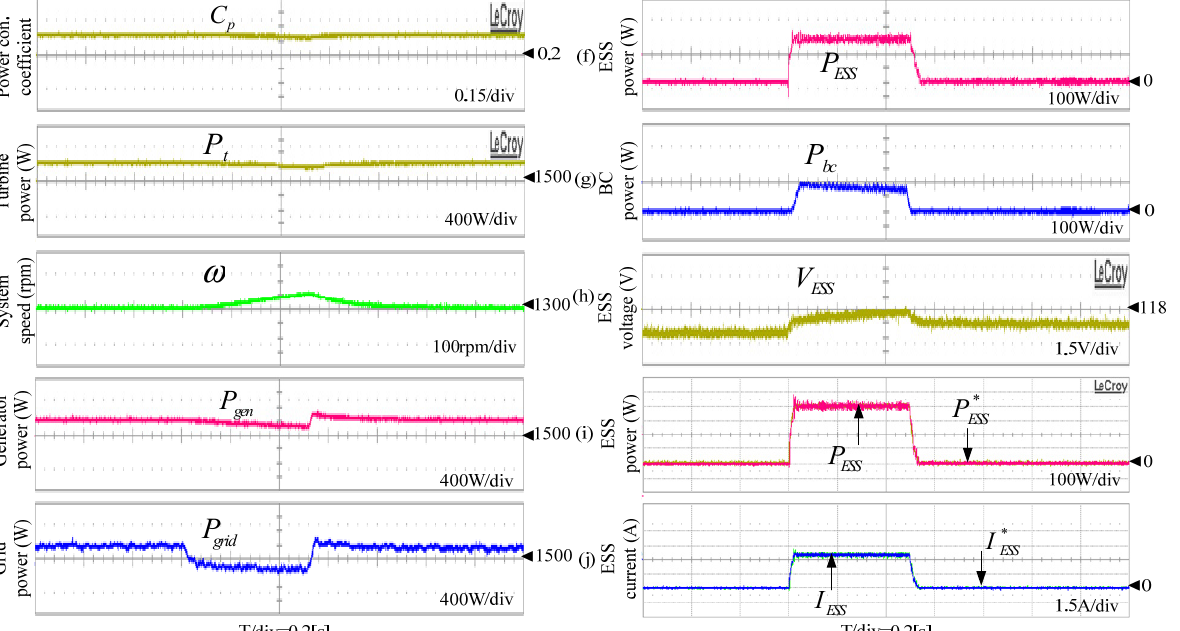
Figure 11. Response of WTS under unbalanced sag. ( a ) Power coefficient. ( b ) Turbine power. ( c ) Turbine speed. ( d ) PMSG power. ( e ) Power flows into the grid. ( f ) Power charging to EDLC. ( g ) Power consuming by BRs. ( h ) EDLC voltage. ( i ) Power controller. ( j ) Current controller.